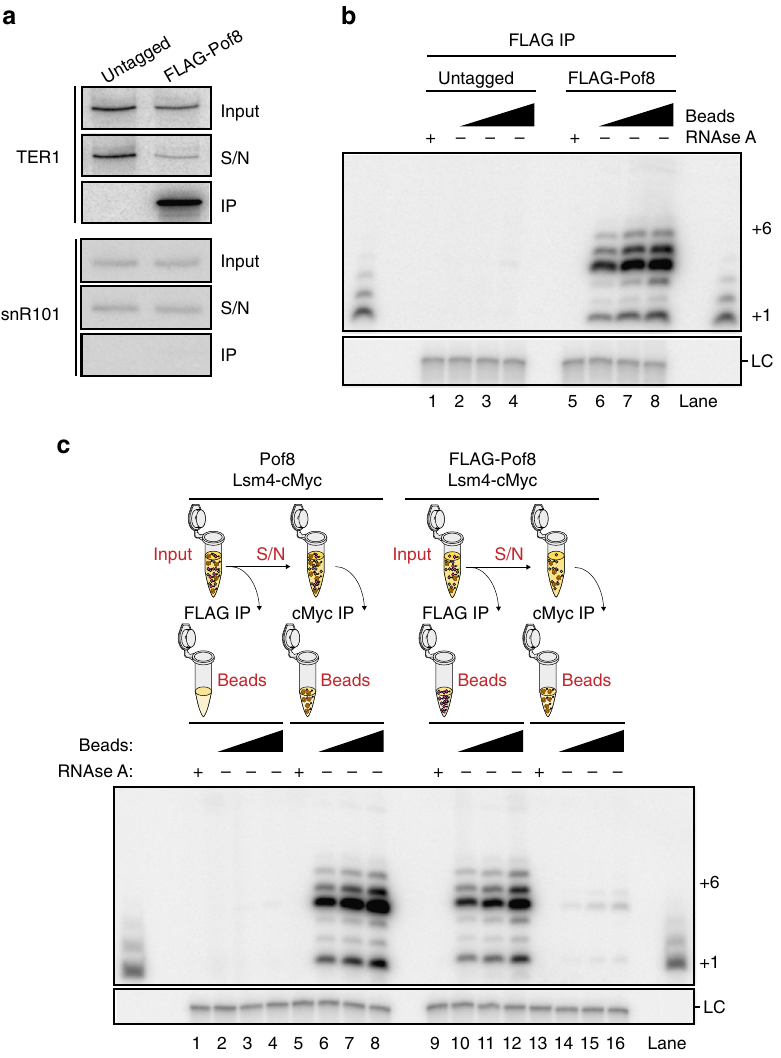
Fig. 6 Pof8 is a constitutive member of telomerase holoenzyme. a Northern blot analysis of TER1 from α -FLAG immunoprecipitation (IP) from Pof8 and FLAG-Pof8 strains. Input and supernatant (S/N) represent 10% of the IP samples. snR101 was used as a negative control. The uncropped blots are presented in Supplementary Fig. 3d. b Telomerase activity assay from FLAG IP samples of FLAG-Pof8 and untagged Pof8 strains in an Lsm4-cMyc background. RNAse A was added to beads before performing telomerase assays in control samples. A ladder of extension products generated by terminal transferase was run on both edges of the gel; the bands corresponding to +1 and +6 nucleotide addition products are indicated on the right. A 32 P-labeled 100-mer oligonucleotide was used as LC. c Telomerase assay of samples generated by sequential IPs with FLAG and cMyc antibodies. A schematic of the experiment is shown above the blot: fi rst, extracts were exposed to α -FLAG antibody-bound beads, the supernatant (S/N) from the α -FLAG IP was then exposed to α -cMyc antibody-bound beads followed by a telomerase assay for all groups of IP samples. The uncropped blot is presented in